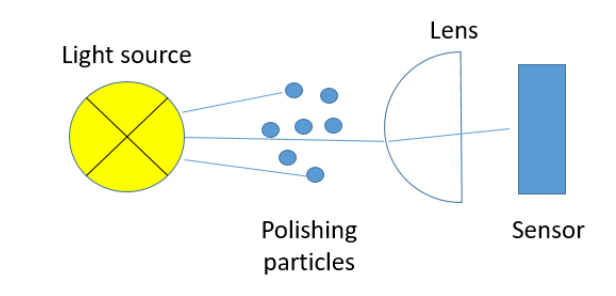
Fig. 1. Operating principle density sensor